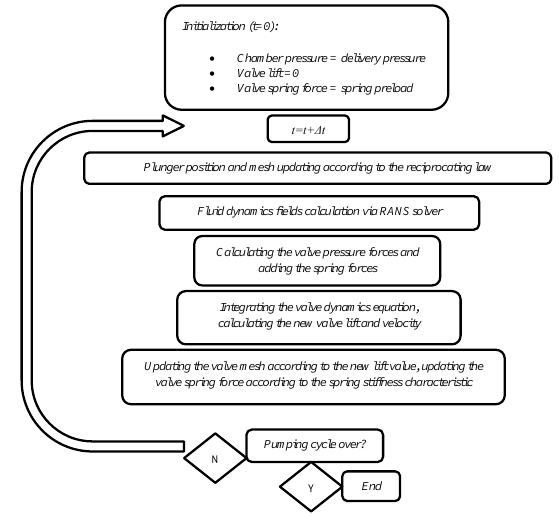
Figure 3: User Defined Function to drive the valve motion, how it relates to the main CFD solver (Iannetti, Stickland, and Dempster 2015)